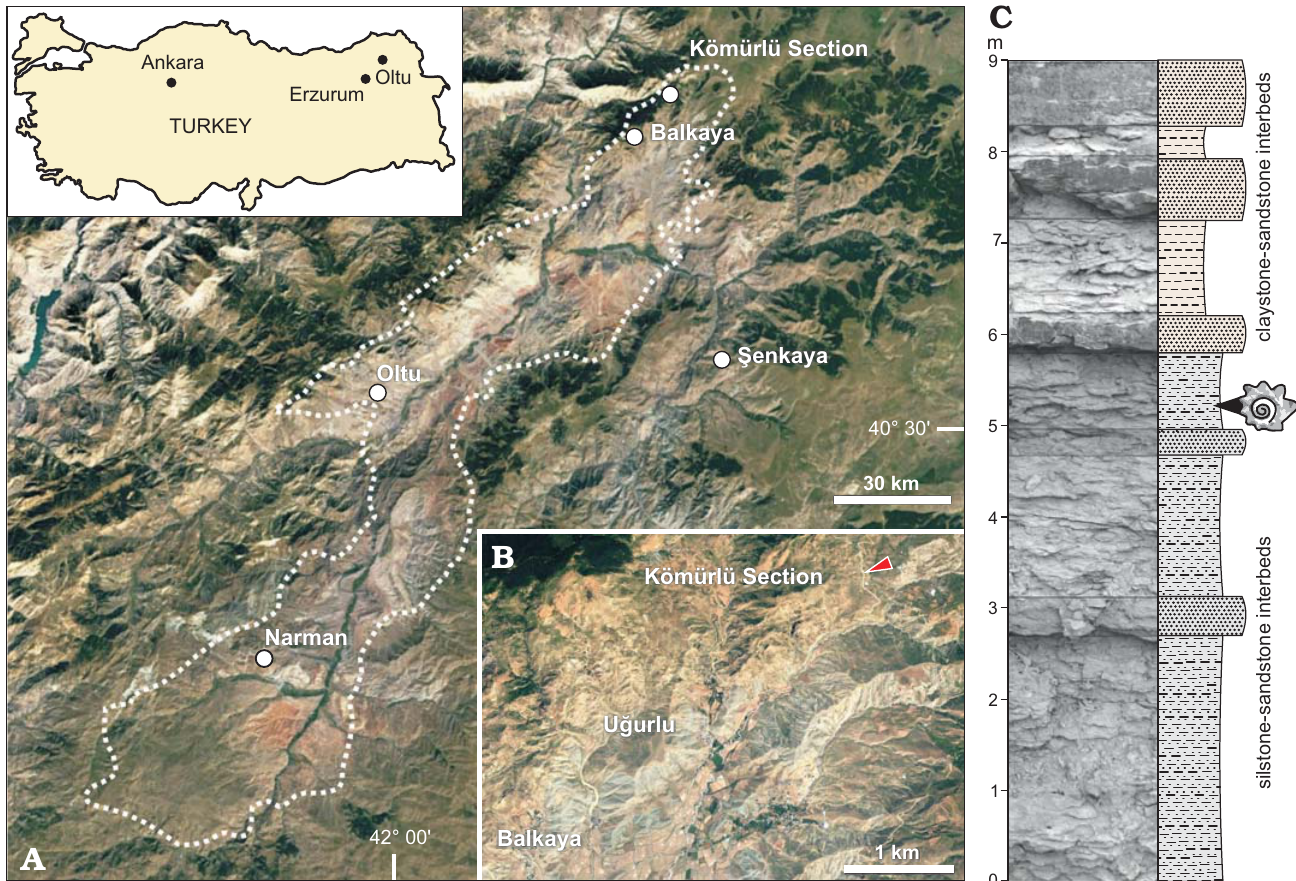
Fig. 1. A , B . Geographic position of the investigated section at the northeastern margin of the Oltu-Narman Basin in Eastern Anatolia ( A ), and detailed map of the position of the Kömürlü section indicated by an arrowhead ( B ). Outline of the Oltu-Narman Basin after Bozku ş (1990); maps generated with Google Earth Version 7.3.1, Image © 2018 Digital Globe; image taken in 7/5/2010. C . Picture and sedimentological log of the Kömürlü